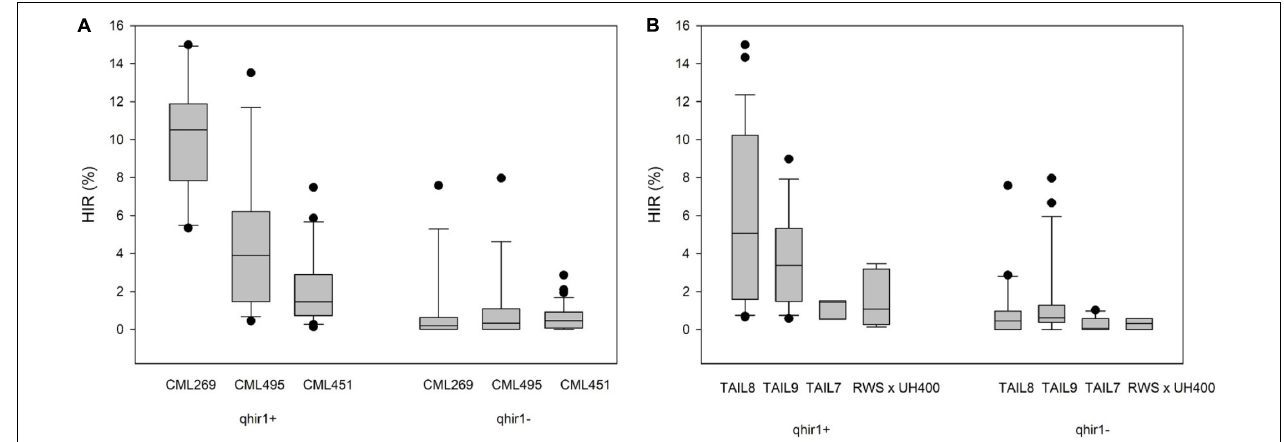
FIGURE 1 | HIR in F5 families with qhir1+ and qhir1– genotypes involving (A) three different non-inducer parents; and (B) four different inducer parents.